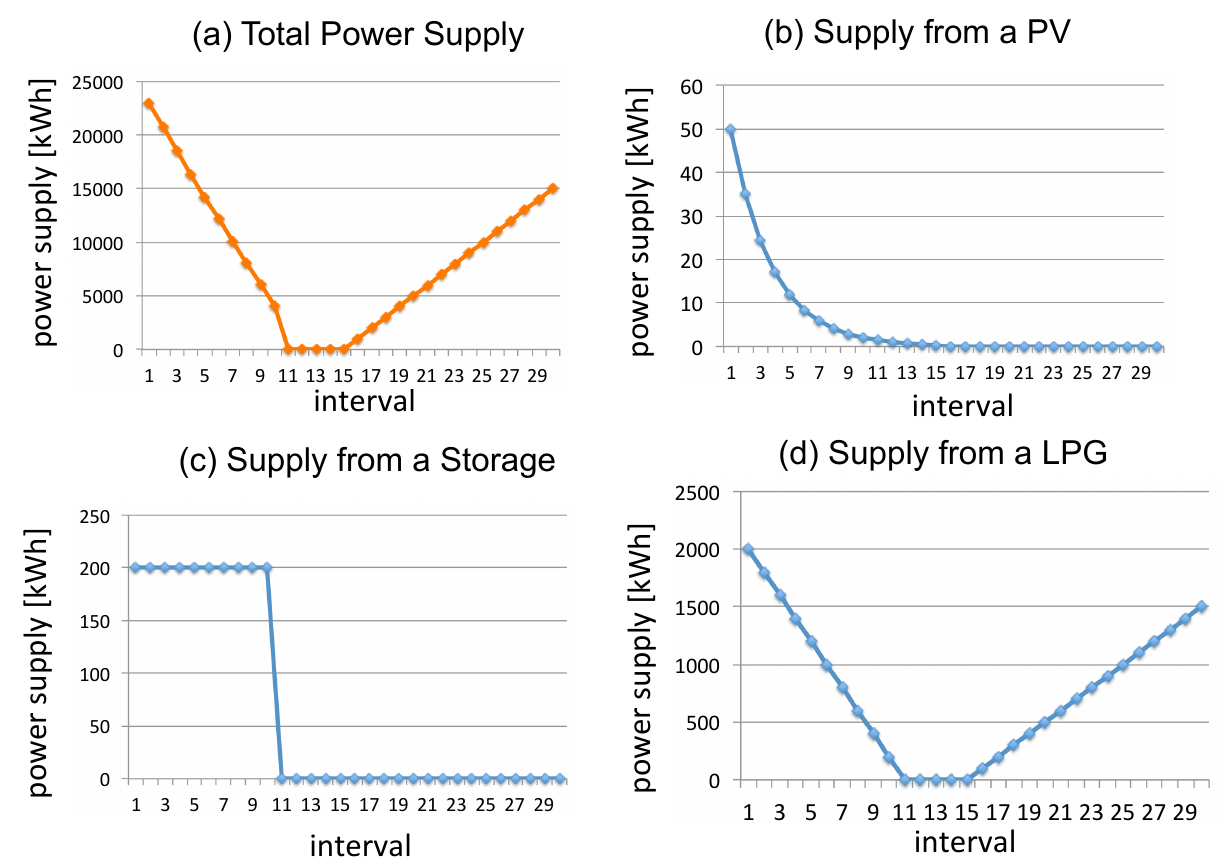
Figure 13. The transition of the power supply from the distributed generators (DGs) and distributed storage